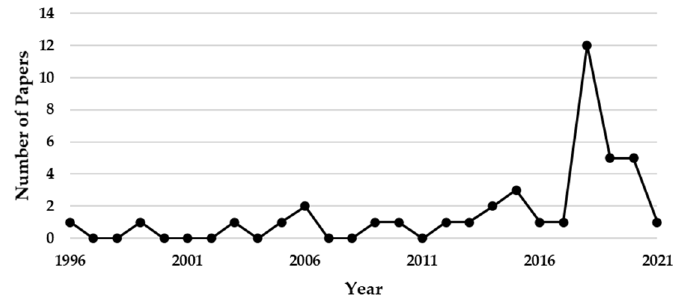
Figure 3. Number of publications papers which met the inclusion criteria per year.